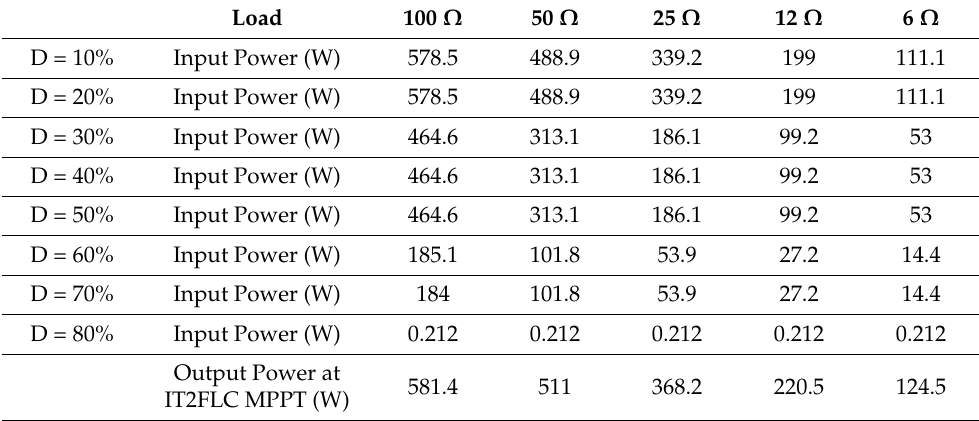
Figure 10. Load switching during the P&O algorithm. Table 4. Manual change of duty cycle at various loads and automatic change of it at IT2FLC MPPT.